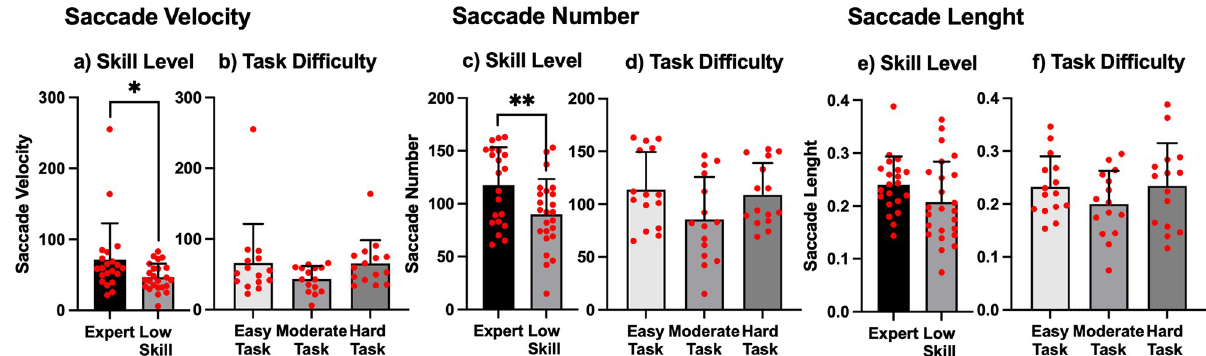
Fig 8. Saccade characteristics. a, b: saccade velocity, c, d: saccade number, e, f: saccade length. Each red circle represents an individual data point. The significance level was set at � p < .05 and �� p <